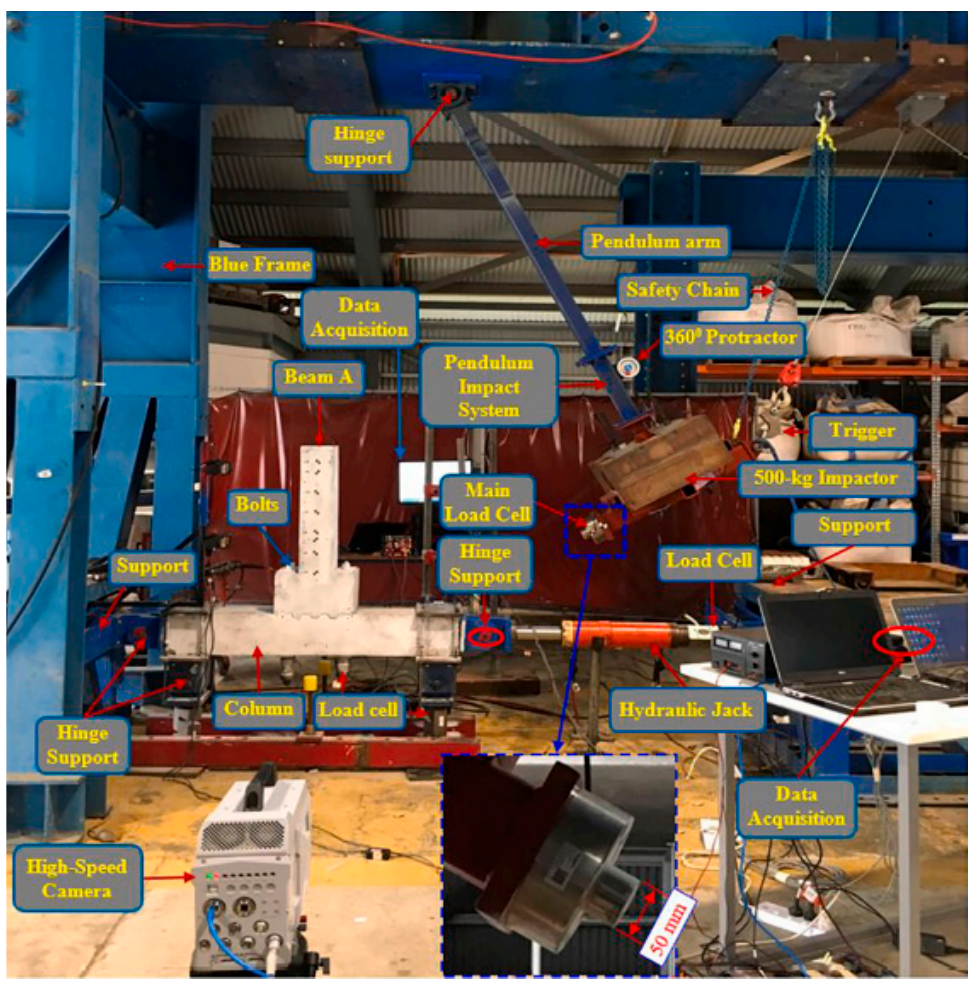
Figure 22. Experimental apparatus for impact testing of beam-column joints [193].